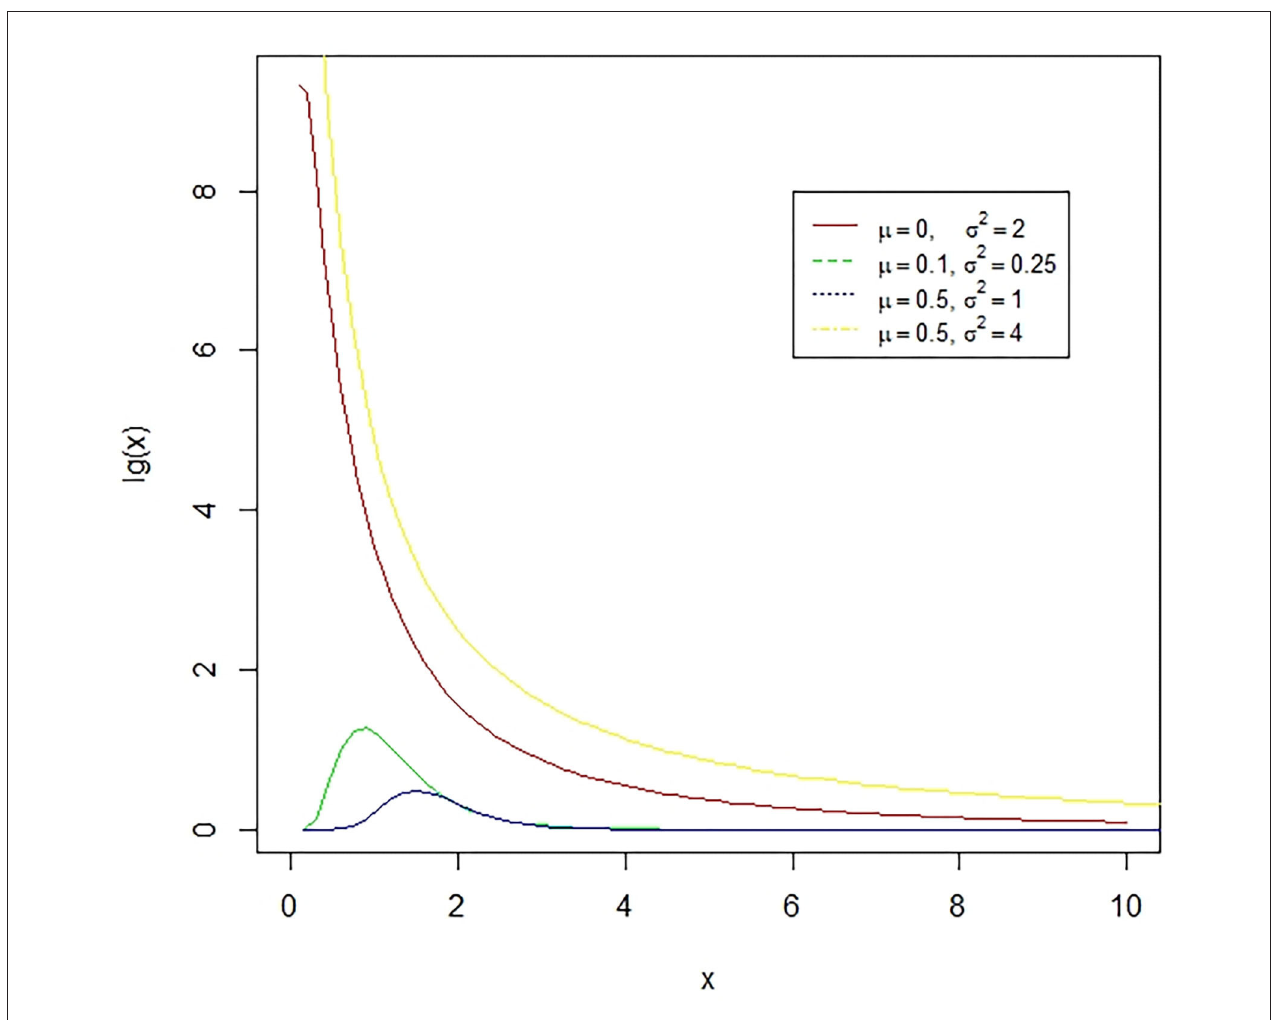
FIGURE 4 | The lognormal distribution is a continuous distribution of a random variable whose logarithm has a normal distribution. E.g., if X is log-normally distributed, then Y = log ( X ) will have a normal distribution. The presented figure represents different normal curves for different values of means and variances.